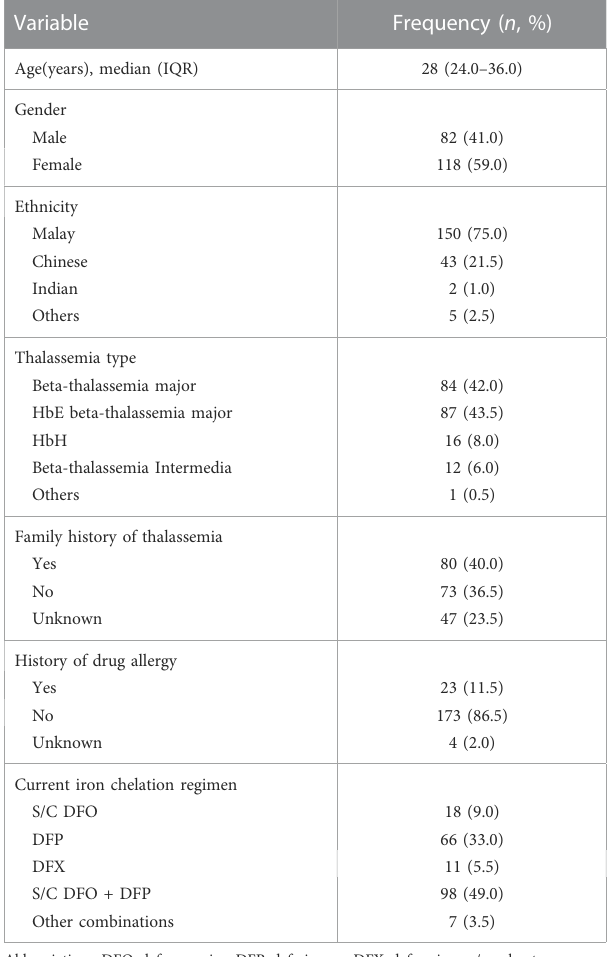
TABLE 1 Demographic and treatment characteristics of transfusion dependent thalassemia patients ( n =